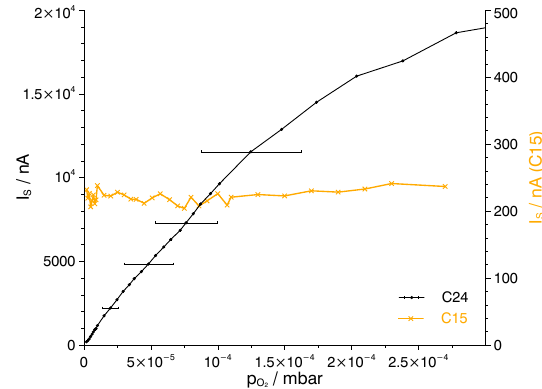
Figure 7. Calibration curves for molecular oxygen sensor C24 with platinum electrodes and for atomic oxygen sensor C15 with gold- plated cathode. Sensor currents are plotted over the O 2 partial pres- sure. The error bars indicate the uncertainty due to the pressure mea- surement.